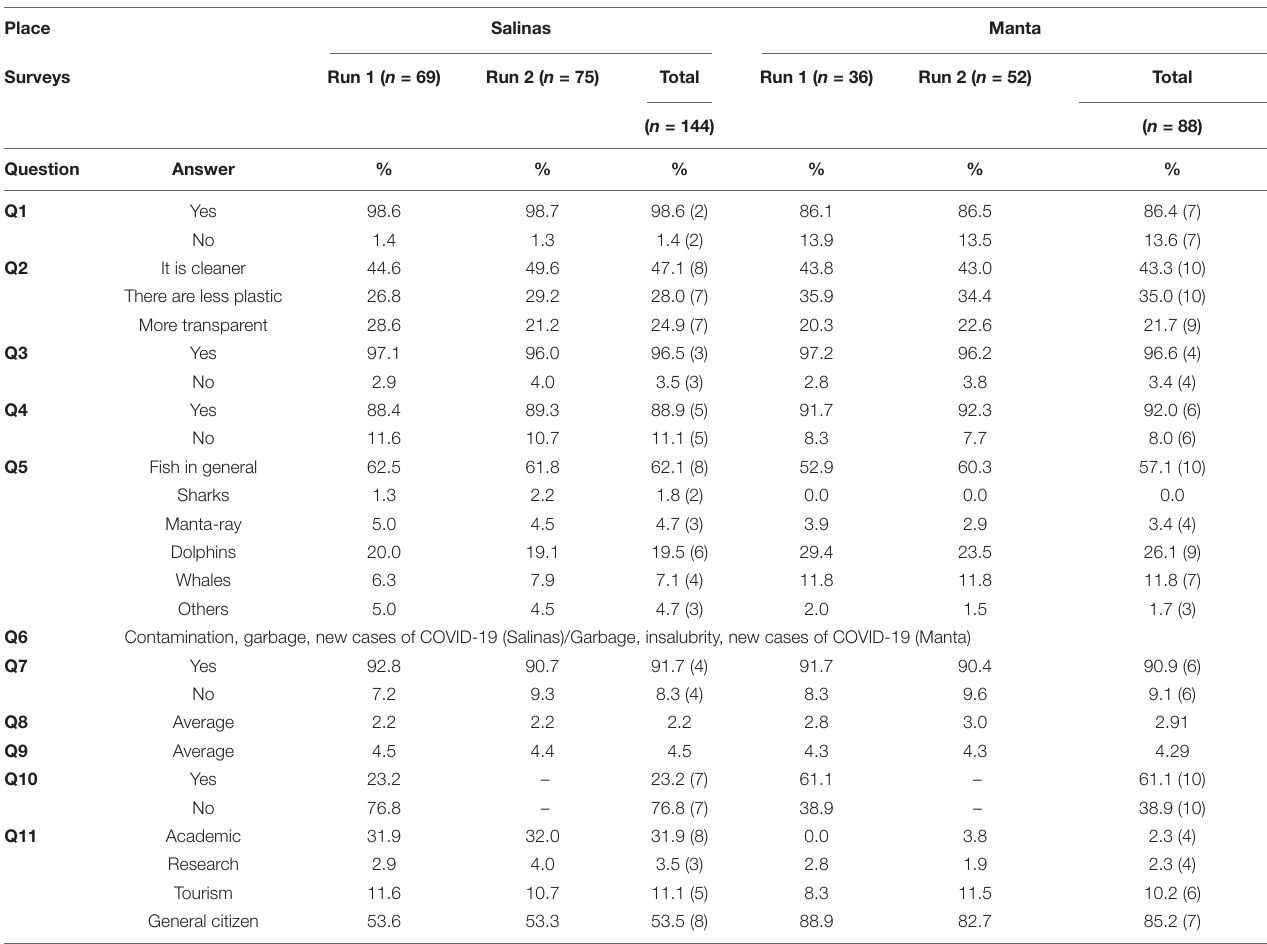
TABLE 1 | Results from Salinas and Manta. Place Salinas